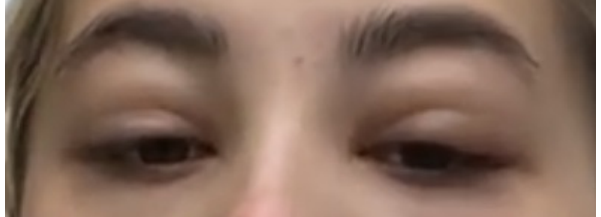
Figure 2. Worsening of oedema during the third week.